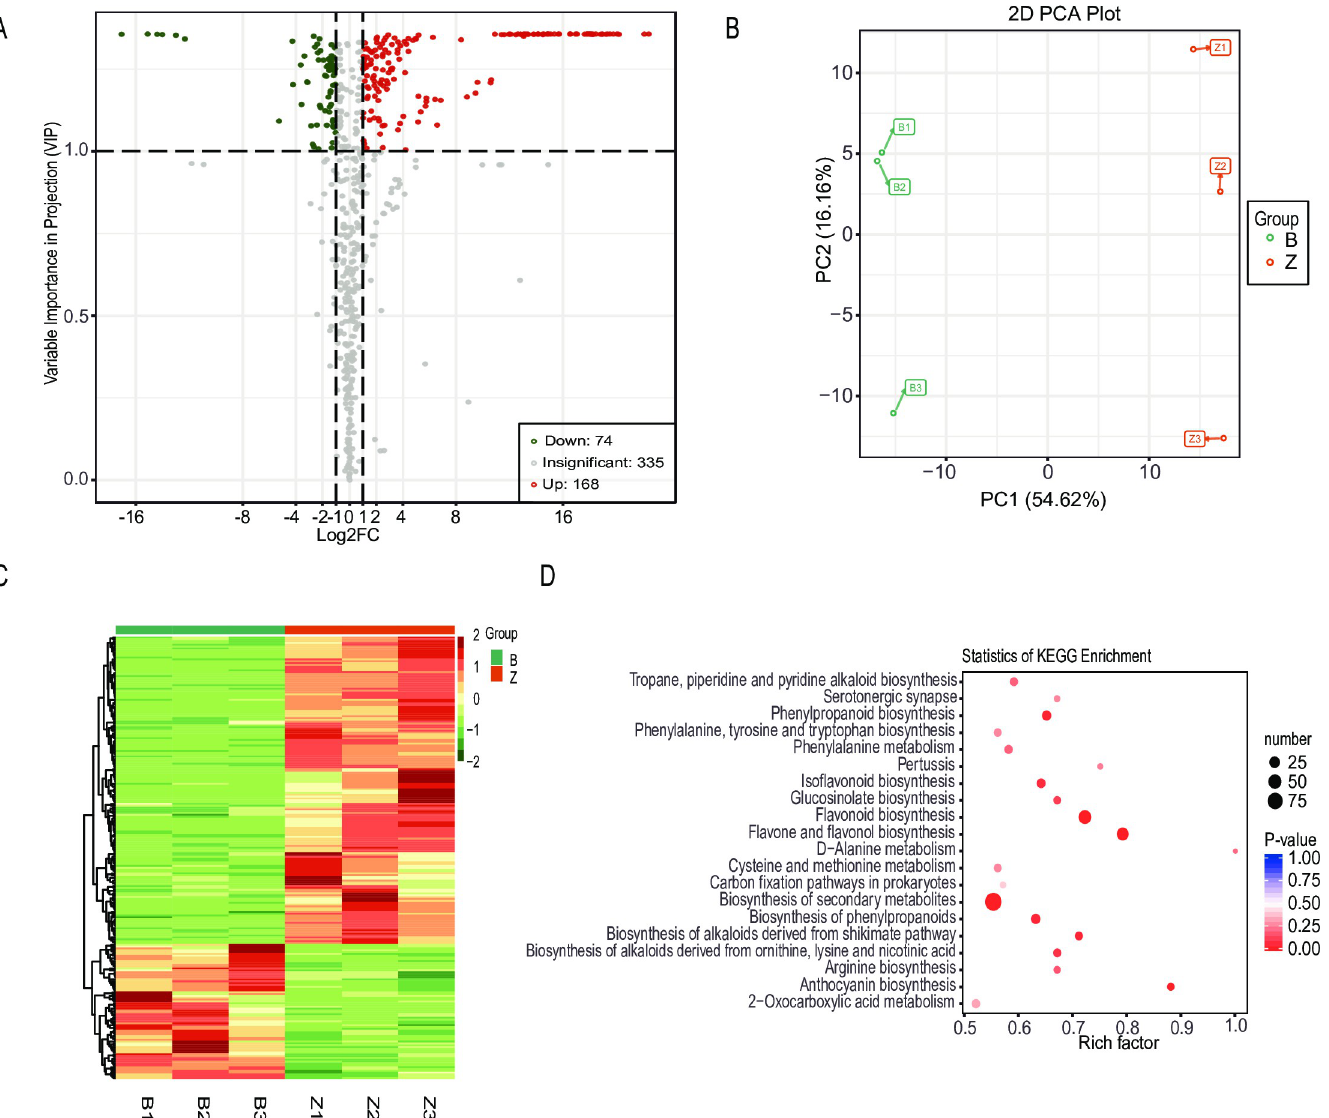
Fig 2. Metabolic differences between dark red and white radish taproots. A. Volcano plots of different metabolites between the dark red and white taproots; B. Principal component analysis (PCA) score map with data from the dark red and white samples; C. A hierarchical clustering graph based on the expression values of all significantly different metabolites identified in dark red and white taproots; D. Kyoto Encyclopedia of Genes and Genomes (KEGG) enrichment of these different metabolites.